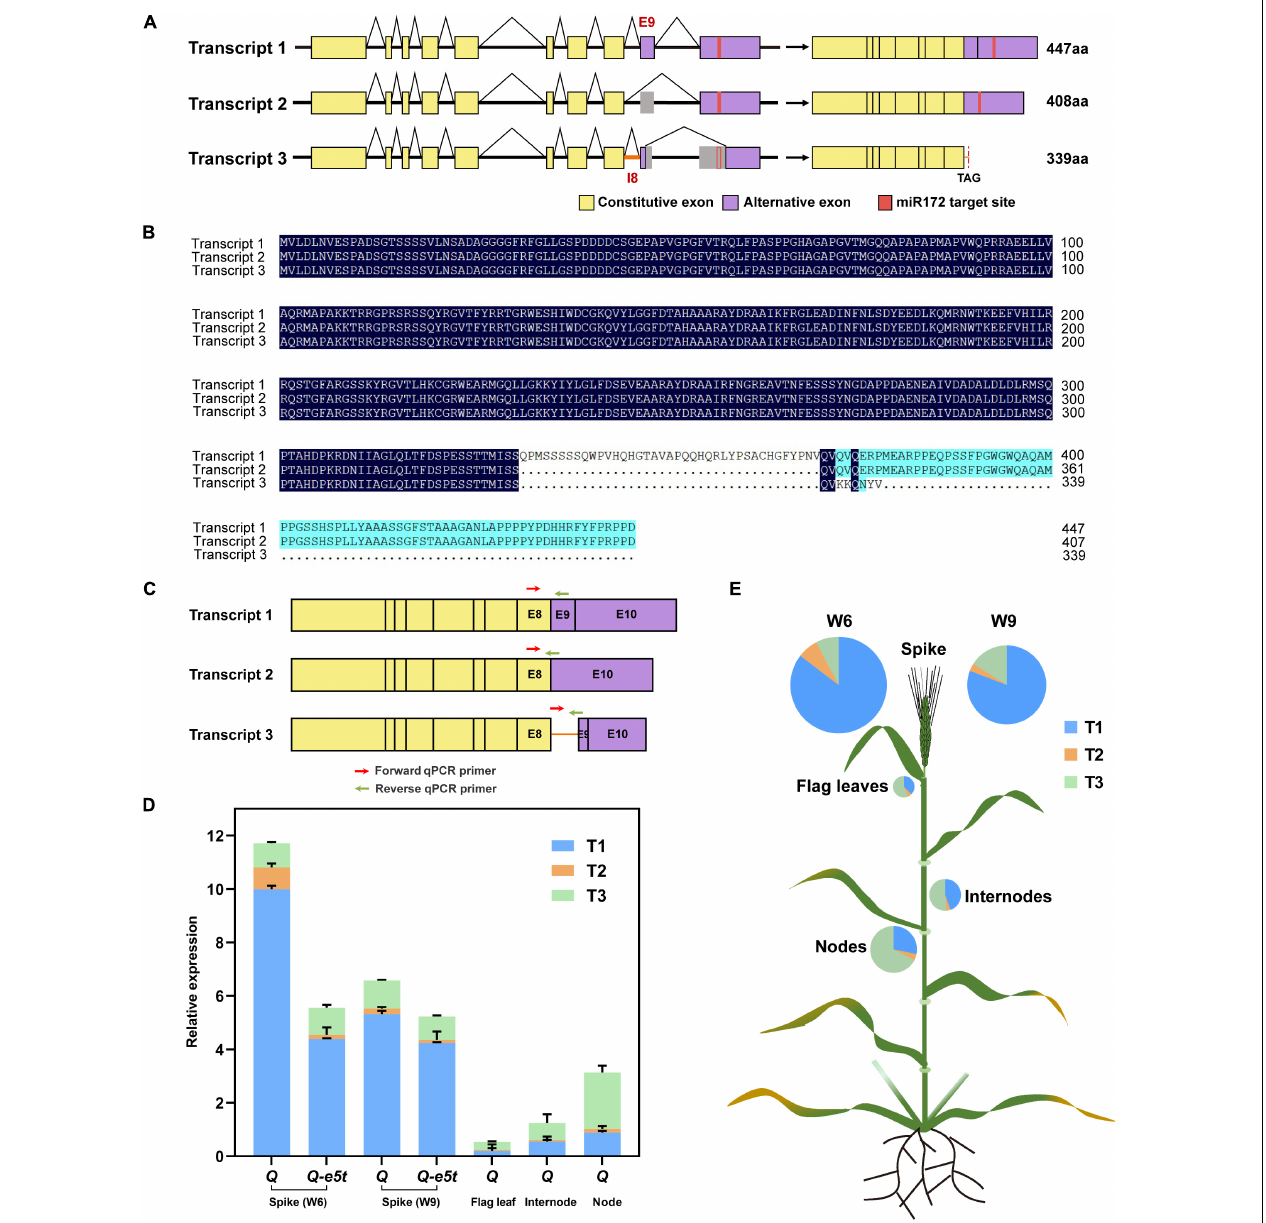
FIGURE 7 | The alternative splicing patterns of the Q gene. (A) The Q gene produced three transcripts, T1, T2, and T3, through alternative splicing. The yellow rectangles indicate constitutive exons, the purple rectangles indicate alternative exons and the red rectangles indicate the miR172 target site of the Q gene. (B) Protein sequence alignment of the three transcripts. (C) Three pairs of specific qPCR primers are indicated on the schematics of three transcripts. The red arrows indicate the forward qPCR primers, and the green arrows indicate the reverse qPCR primers. (D) The relative expression levels of the three transcripts of the Q and Q-e5t alleles in spikes (W6 and W9 scales), flag leaves, internodes and nodes. The data are presented as the mean, and the error bars indicate the SD. (E) The expression levels of the three transcripts are indicated in the wheat schematic. The sizes of the pies indicate the total expression levels of all the